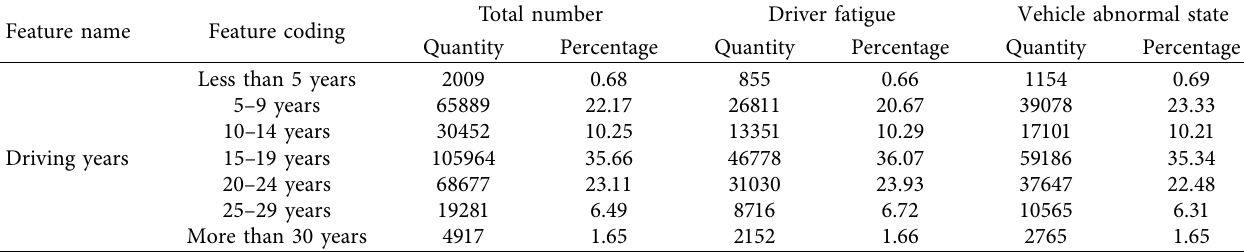
Table 6: Distribution of bus forewarning types for drivers of different driving years.